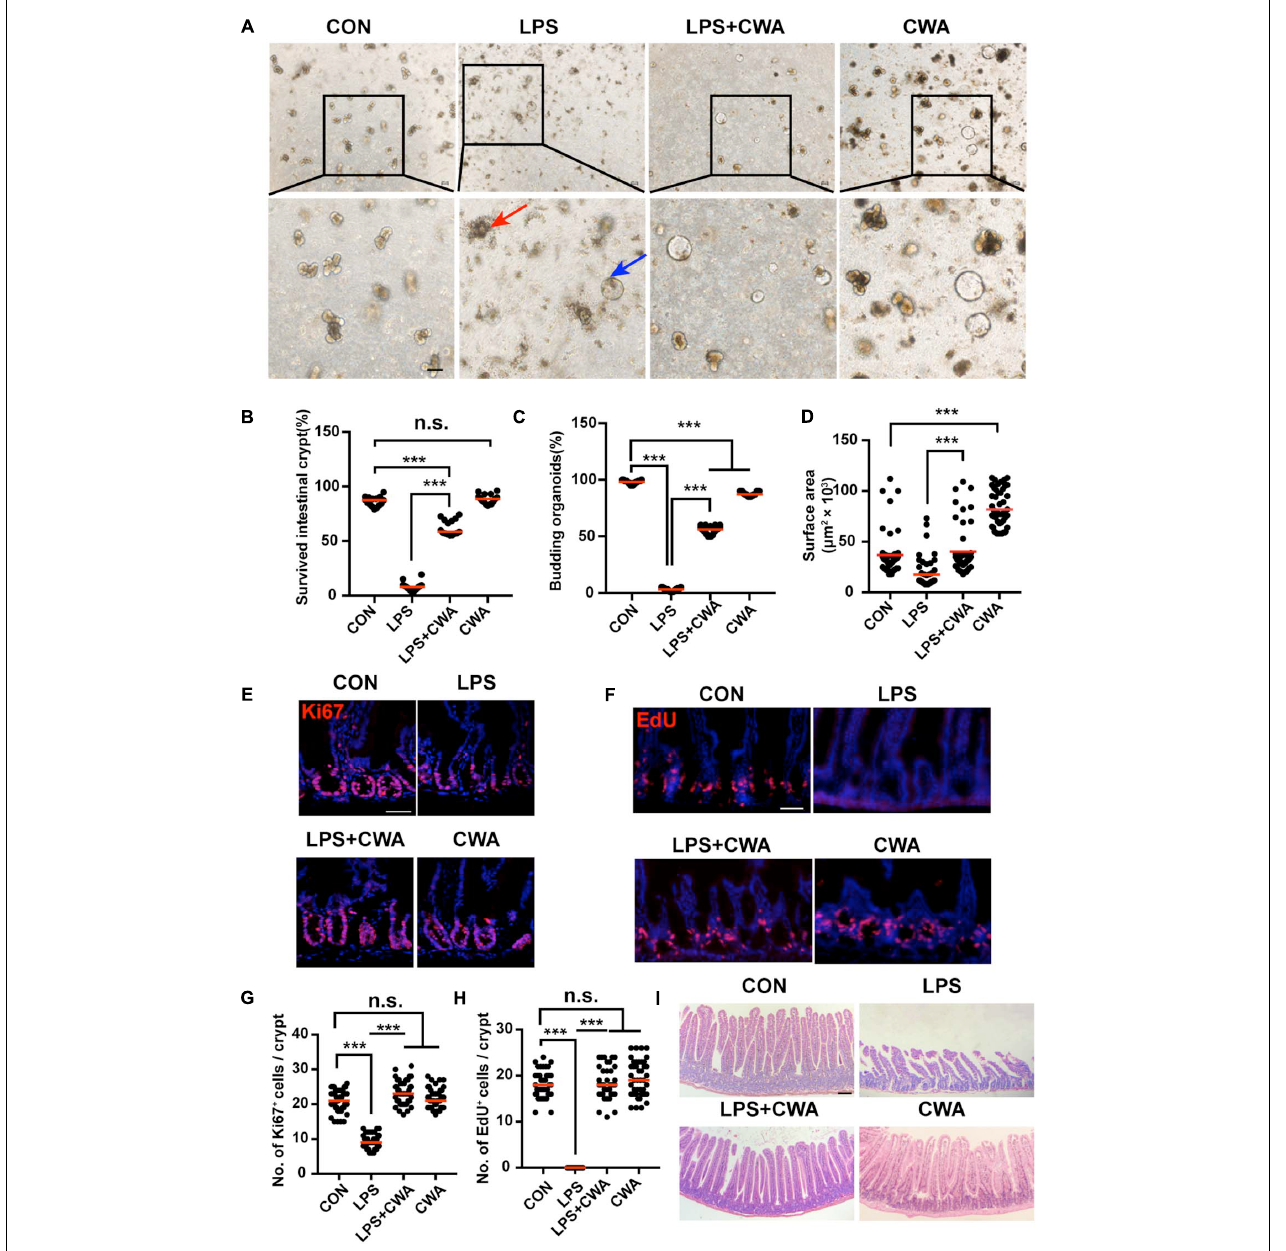
FIGURE 4 | CWA preserves ISCs viability and promotes epithelial regeneration. (A) Representative bright-field images of crypts after 4 days of culture in ENR medium. Red arrowhead indicates collapsed organoids, blue arrowhead indicates survived organoids. Scale bars, 100 µ m. (B) Survival rate of crypts isolated from each group. (C) Organoid budding, percentage of total organoids per well. (D) Size of SI organoids cultured in ENR medium. (E) Representative confocal microscopy images of Ki67 positive cells in crypts. Scale bars, 50 µ m. (F) Representative immunofluorescence images of EdU positive cells. Scale bars, 50 µ m. (G) Quantification of Ki67 + cells in each crypt. (H) Quantification of EdU + cells in each crypt. (I) H&E staining of jejunum sections at 24 h after CWA administration. Scale bars, 100 µ m. *** P < 0.001 by two-sided, unpaired t -test. All data represent at least three independent